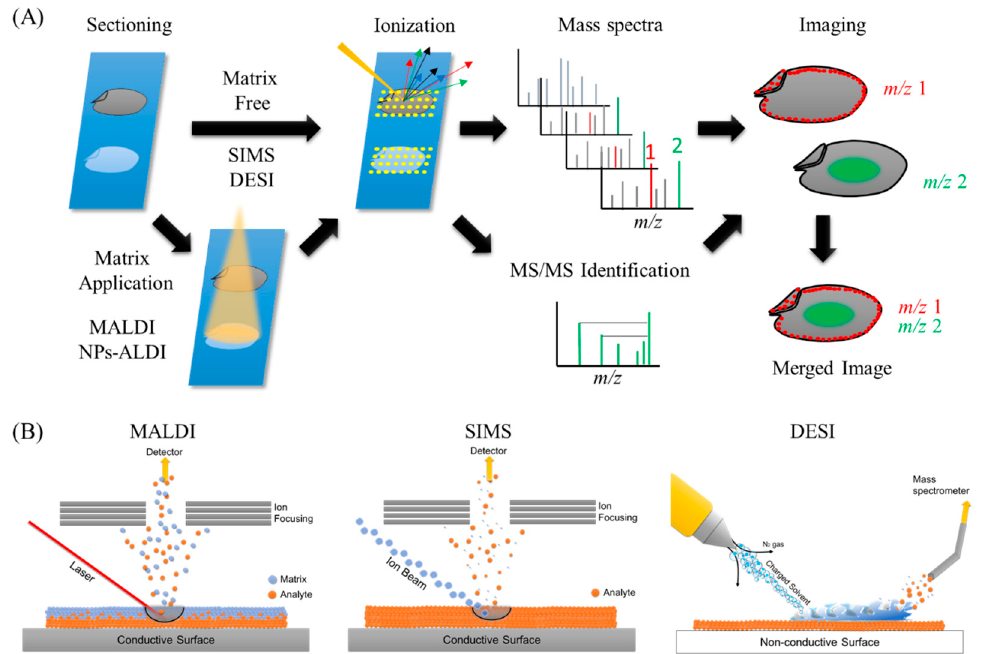
Figure 1. Ionization processes of the most widely used methods in mass spectrometry imaging (MSI) and the general overview of MSI workflow. ( A ) General overview of MSI workflow. Thin-section samples are mounted on a plate, coated with or without matrix. Then, by using a laser (matrix-assisted laser desorption/ionization (MALDI)), ion beam (secondary ion mass spectrometry (SIMS)), or charged solvent droplets (desorption electrospray ionization (DESI)), ions are produced which are detected by a mass spectrometer. Mass spectra are obtained from every single data point. These data are compiled into a single dataset where the occurrence of any single mass can be visualized as a scaled false color. Molecules of interest can be visualized and identified by MS/MS on tissues. ( B ) Ionization mechanisms involved in MALDI, SIMS, and DESI ionization sources.